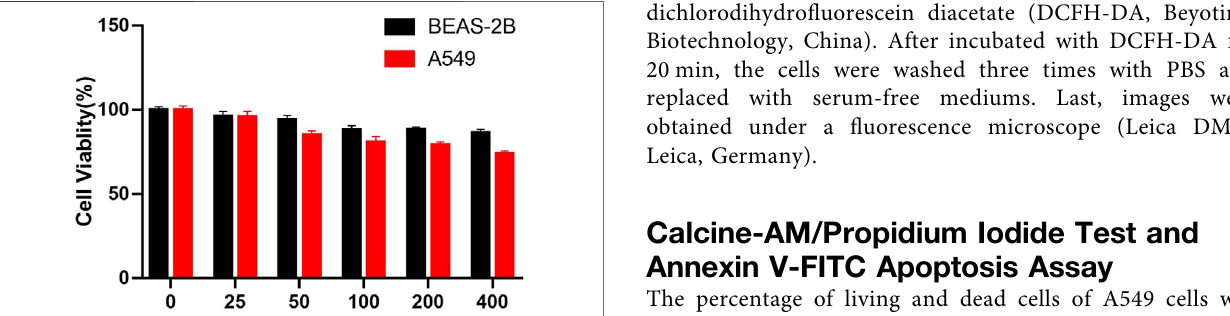
Frontiers in Bioengineering and Biotechnology |